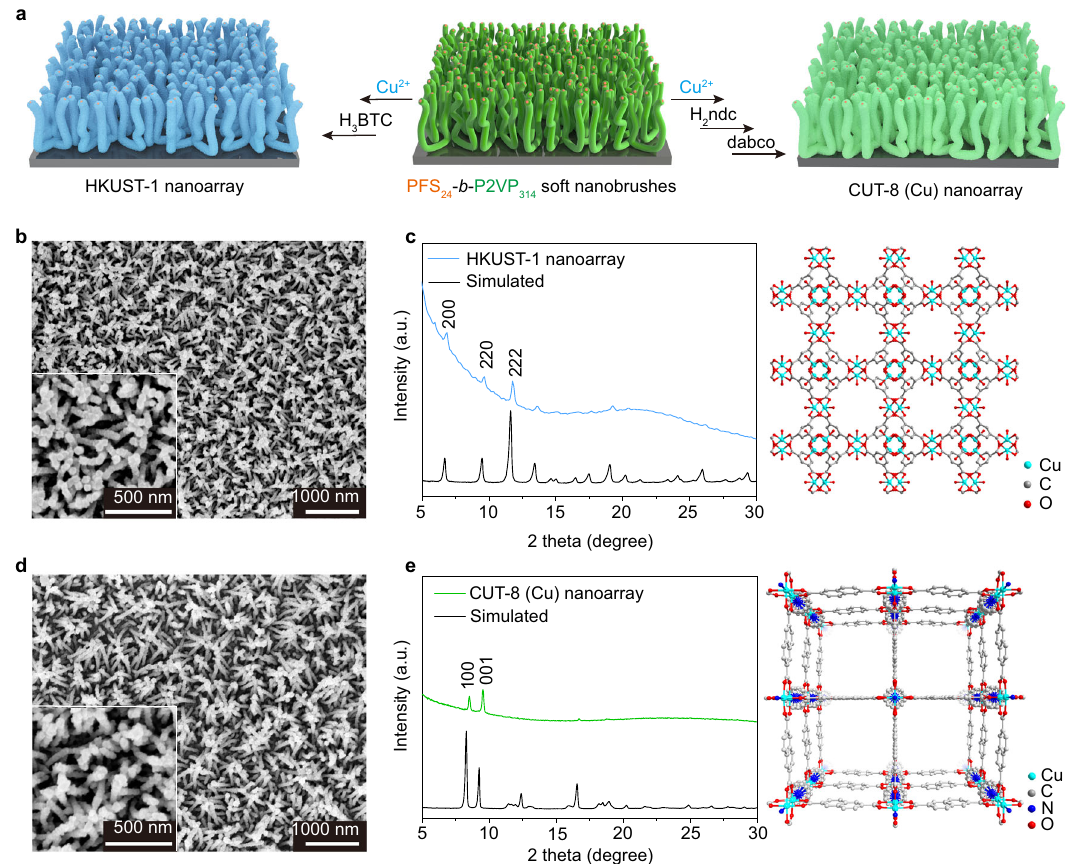
Fig. 4 | Extension of soft nanobrush-directed MOF nanoarrays. a Scheme illus- tration of the fabrication process for HKUST-1 and CUT-8 (Cu) nanoarrays. b SEM images of an HKUST-1 nanoarray obtained by alternately immersing a soft nanobrush-coatedsiliconwaferintoethanolsolutionsofCu(CH 3 COO) 2 andH 3 BTC for fi ve cycles. c XRD pattern of the obtained HKUST-1 nanoarray and simulated XRD pattern of HKUST-1. The right image shows the crystal structure of HKUST-1. d SEM images of a CUT-8 (Cu) nanoarray obtained by alternately immersing a soft